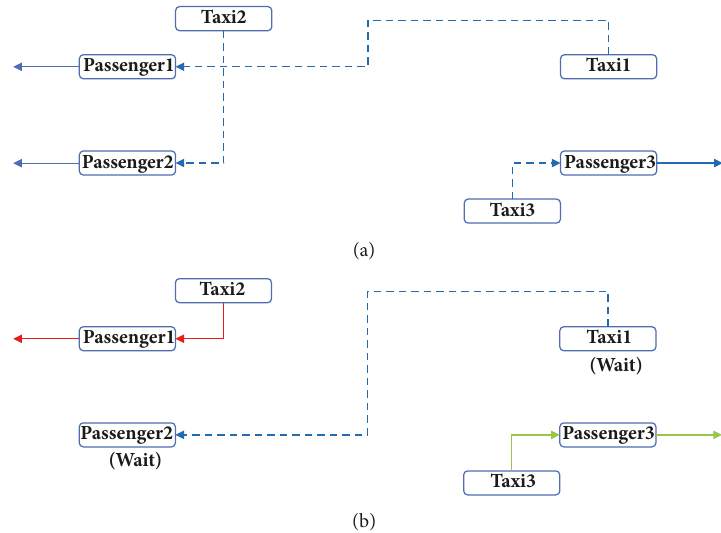
Figure 4: Routing comparison of a hypothetical example. (a) Original vehicle routing. (b) Improved vehicle routing.